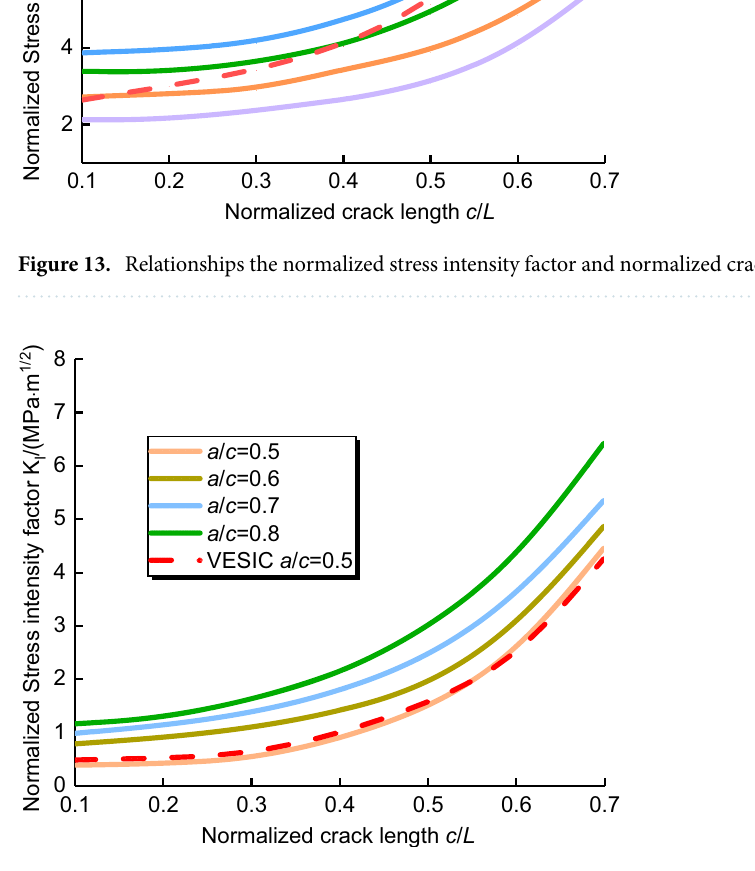
Figure 14. Relationships the normalized stress intensity factor and normalized crack length (0.5 ≤ a / c ≤